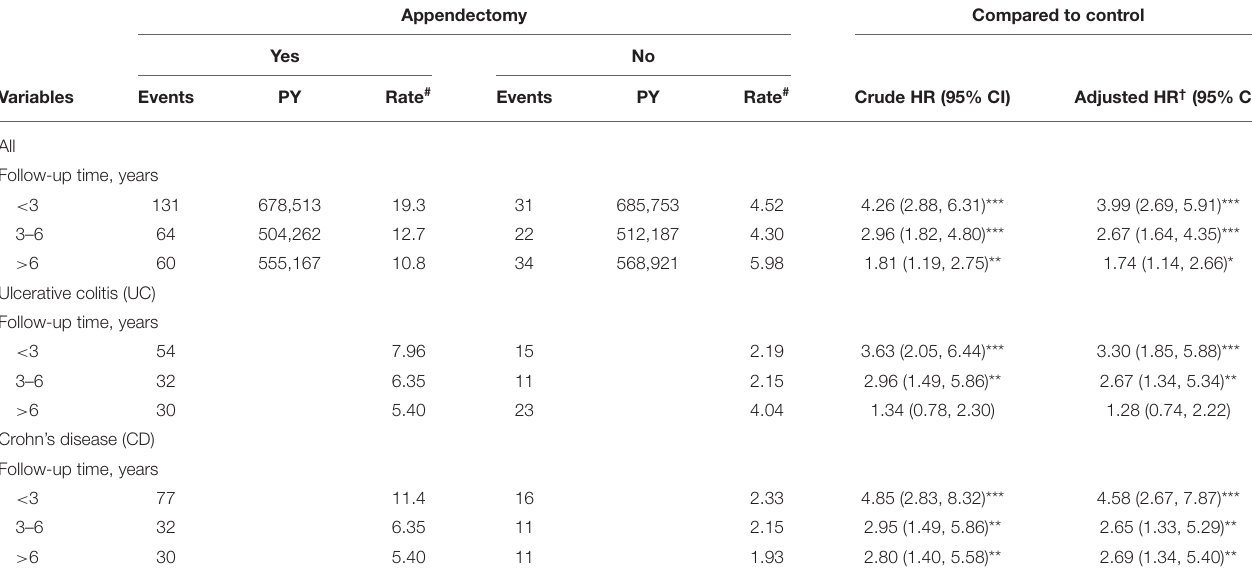
TABLE 3 | Incidence and adjusted hazard ratio of inflammatory bowel disease based on follow-up period for patients with appendectomy compared with controls. Appendectomy Compared to control